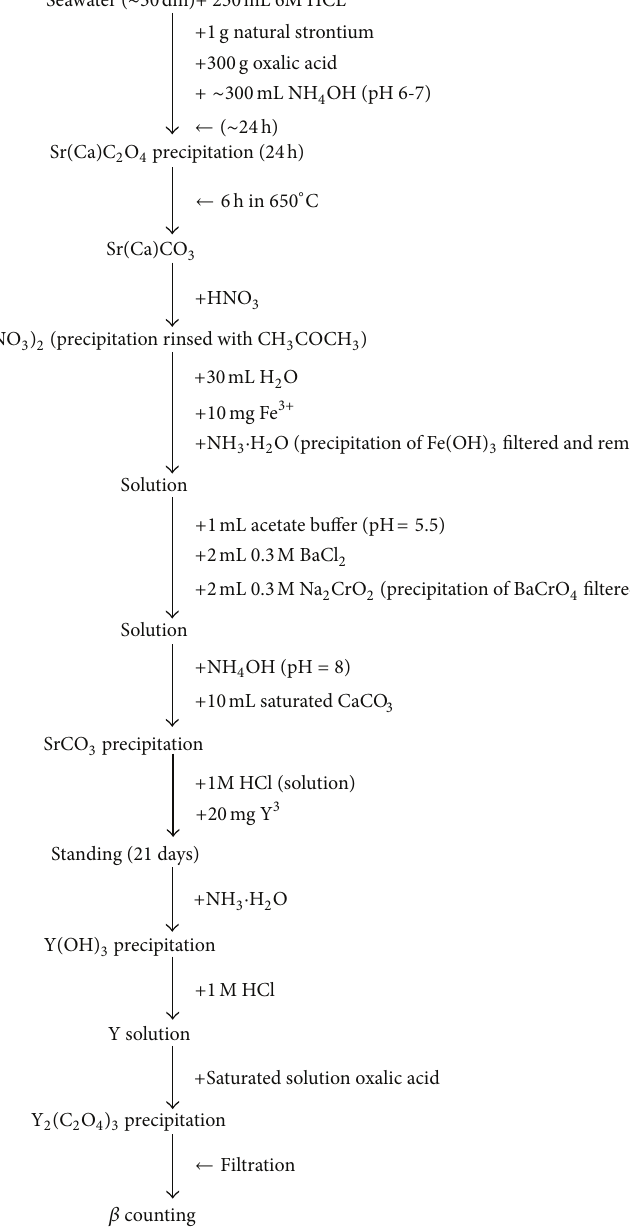
Figure 2: A flow chart of the analytical procedures used for 90 Sr determination in seawater